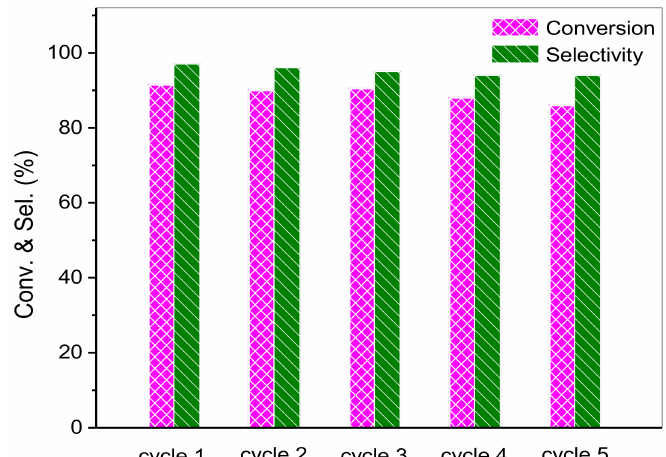
Figure 9. Recycled photoactivity test for five operational runs over the optimal HTT/graphene-1.0%, on selective oxidation of benzyl